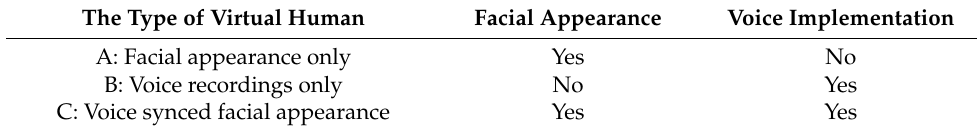
Table 3. The types of virtual humans manipulated in the politeness norm